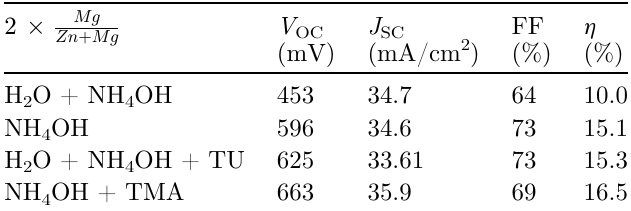
Table 4. PV parameters of best devices with single TMA pulse during buffer deposition. “ B ” refers to a single cycle of 4Mg O, TMA before buffer deposition, “ M ” refers to a single TMA 0.8 0.16 pulse midway during buffer deposition.